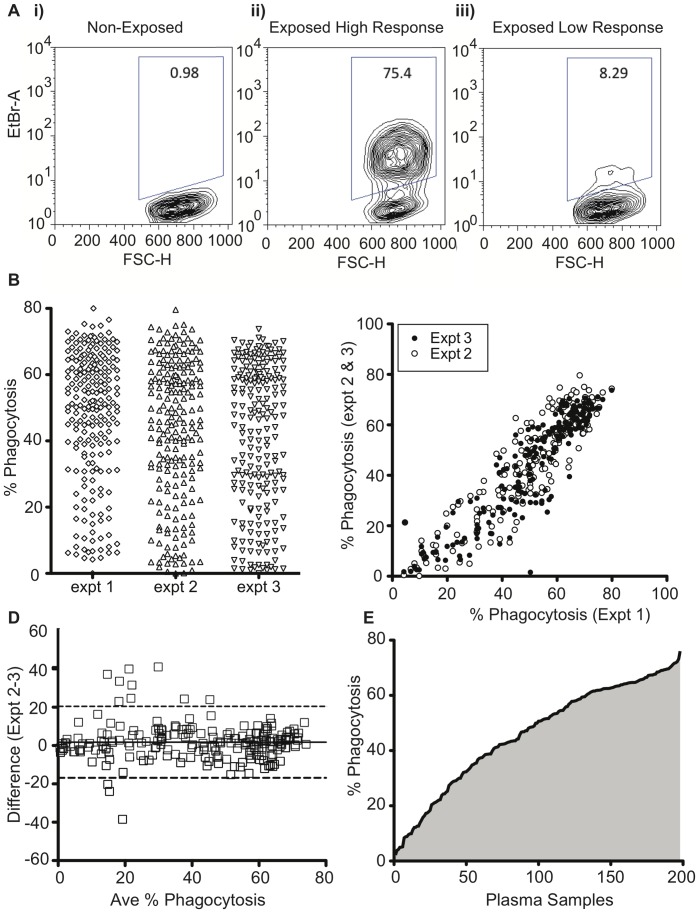
Phagocytosis responses are robust and reproducible.A) EtBr stained merozoites were incubated with plasma, and were added to THP-1 cells. EtBr fluorescence was determined by flow cytometry, and THP-1 cells gated by forward and side scatter. Representative flow cytometry plots show EtBr positive events with i) a pool of non-exposed Australian plasma ii) plasma from an exposed PNG donor that resulted in a high response and iii) PNG donor plasma that resulted in low responses. B) Percentage phagocytosis was calculated for 198 plasma samples from PNG children in three independent experiments. C) Interassay comparisons as determined by Spearman correlation (expt1 vs. expt2 rs  = 0.91, p<0.0001; expt1 vs. expt3 rs  = 0.93 p<0.0001) and by D) Bland-Altman test (expt1 vs. expt2 bias  = 5.39, sd  = 8.73; expt1 vs. expt3 bias  = 1.79, sd  = 9.3). E) The average % phagocytosis responses from three experiments were ranked by magnitude.